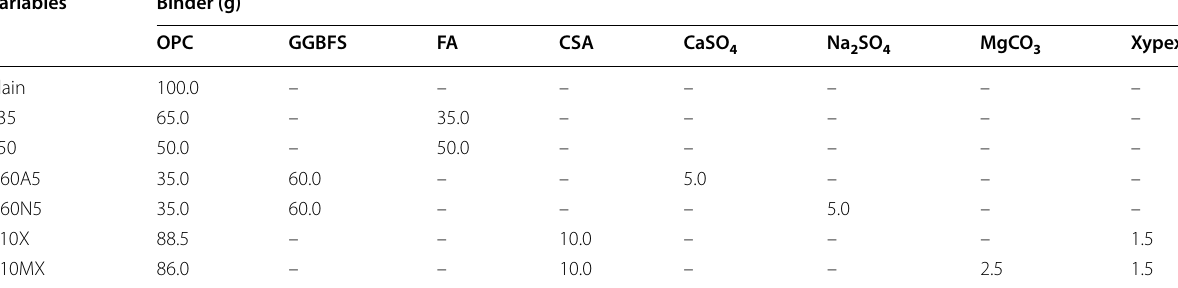
Table 3 Mixture proportions of binders.